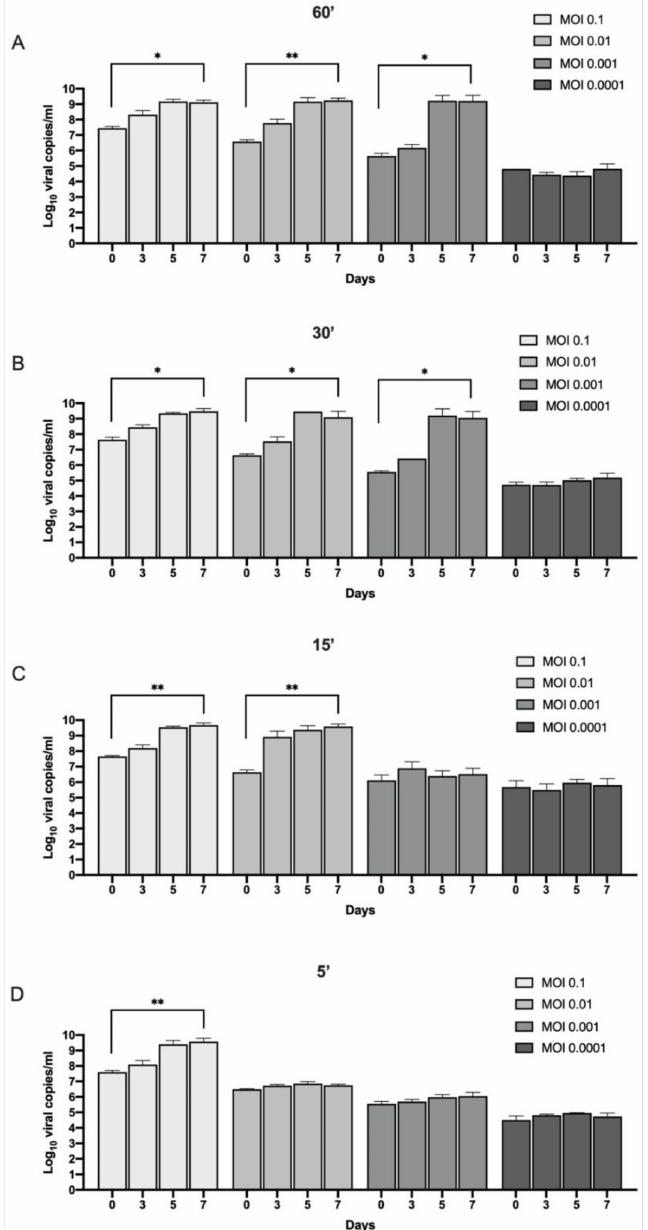
Figure 1. The RNA viral load (expressed as Log10 RNA viral copies/mL) at 0, 3, 5 and 7 day post infection at the different MOI (0.1, 0.01, 0.001, 0.0001) and time of absorption (( A ) 60 min; ( B ) 30 min; ( C ) 15 min; ( D ) 5 min). Results from Kruskal–Wallis test are displayed. ** p < 0.01, * p <